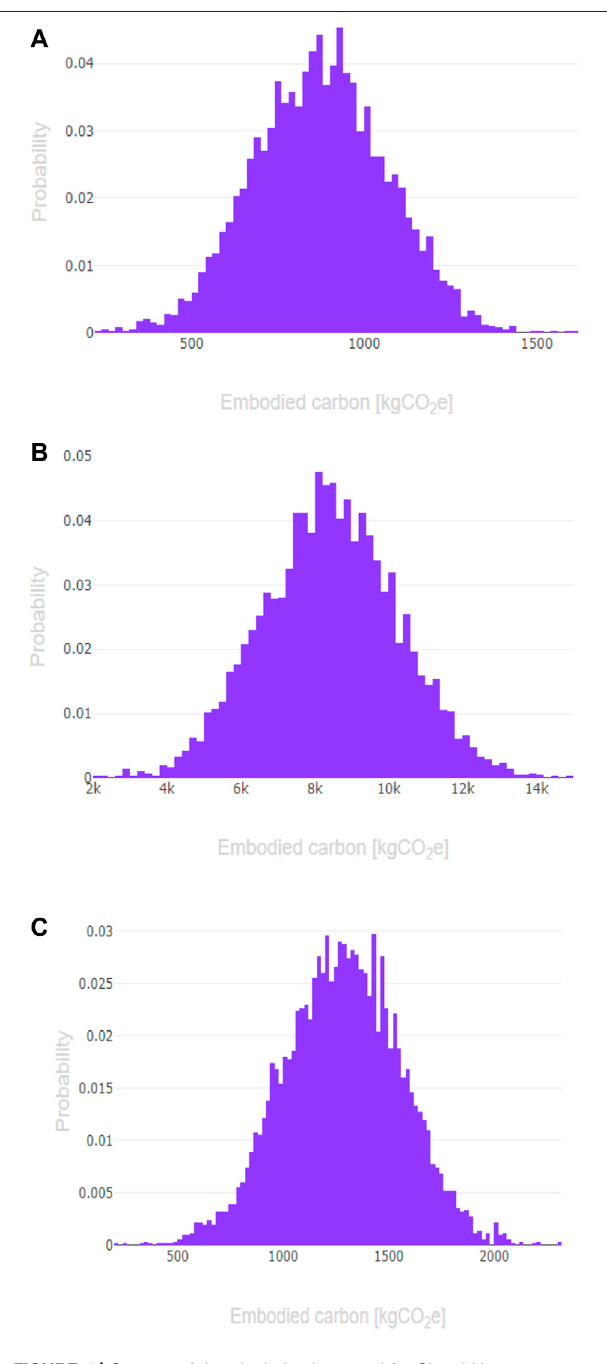
FIGURE 4 | Outputs of the plugin implemented for SketchUp. Histograms of the overall embodied carbon estimates are plotted for each of the three structural types, namely: (A) Steel frame; (B) Reinforced Concrete frame and (C) Engineered timber frame. Please note the plots do not refer to the same structure or underlying assumptions so numbers on the x-axis do not represent a comparison between the three structural materials. These are only shown to exemplify the potential outputs users would getand the possibility ofthe tool to assess structures with very low [e.g. panel (A) ] as well as very high [e.g. panel (B) ] embodied carbon.